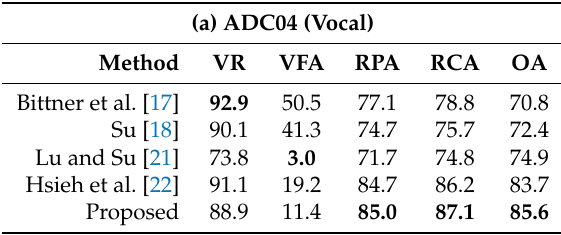
Table 3. Comparison of vocal melody extraction results. The best score in each column is highlighted in